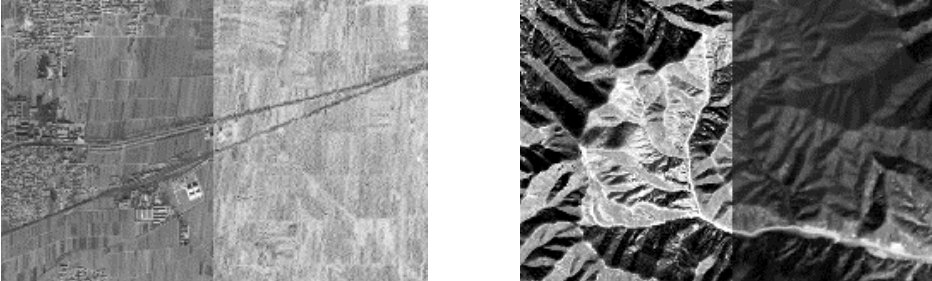
Figure 6: The sketch map of mosaic DOM （ left: plan area; right: mountain area